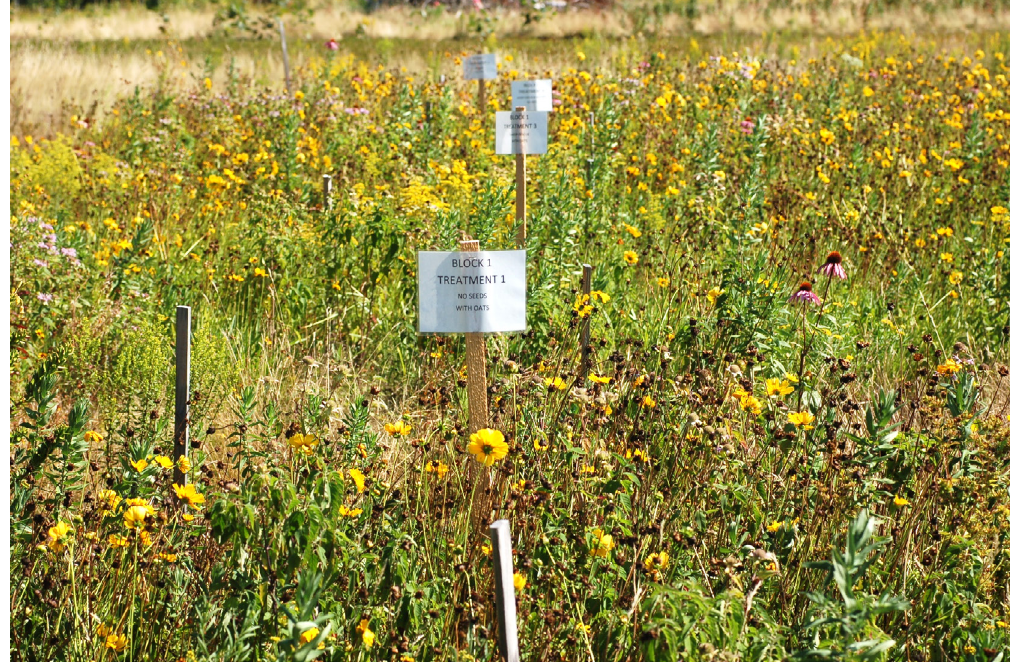
Figure 3: Late summer photo of pollination reservoir in Maine. Photograph of Block 1 study plots taken August 30 th ,